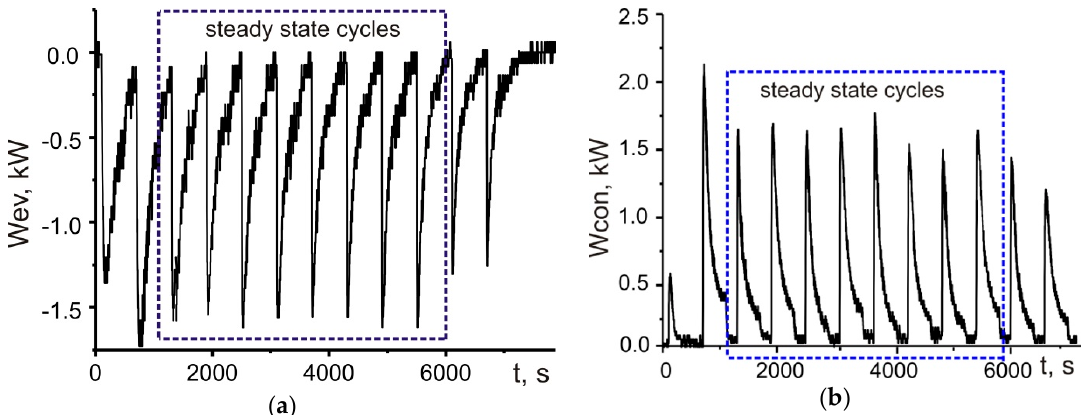
Figure 5. Thermal power consumed in the evaporator ( a ) and released in the condenser ( b ). The duration of the adsorption–desorption stage is 400 s.